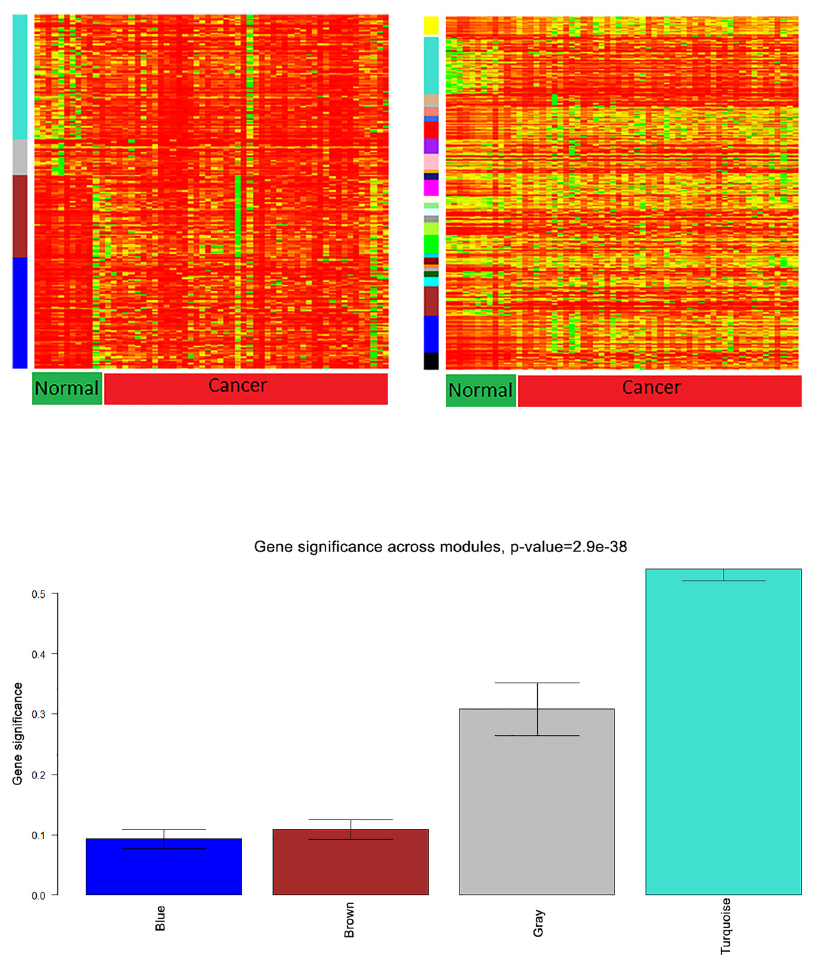
Figure 4: Gene significance of miRNA modules.